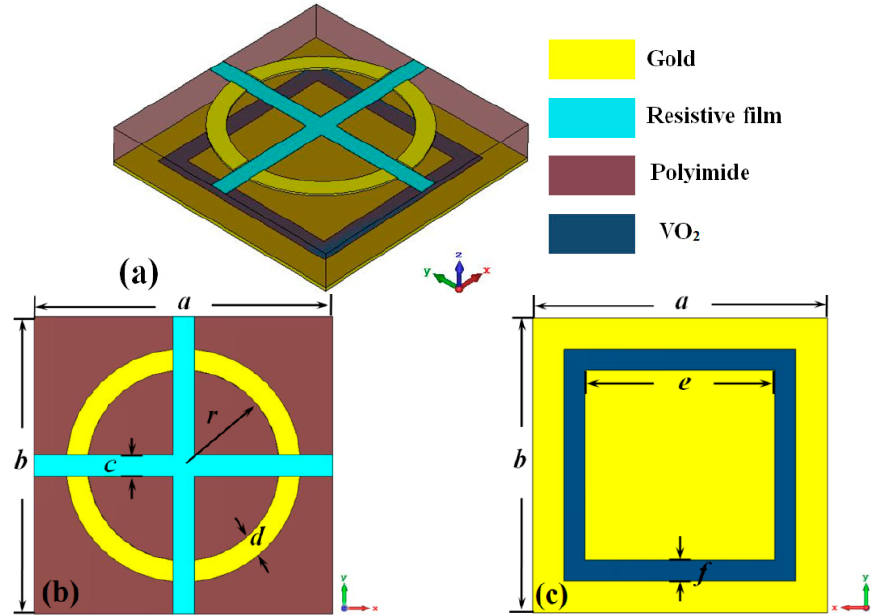
Figure 1. The unit cell of the metamaterial absorber. ( a ) Perspective view; ( b ) front view; and ( c ) back